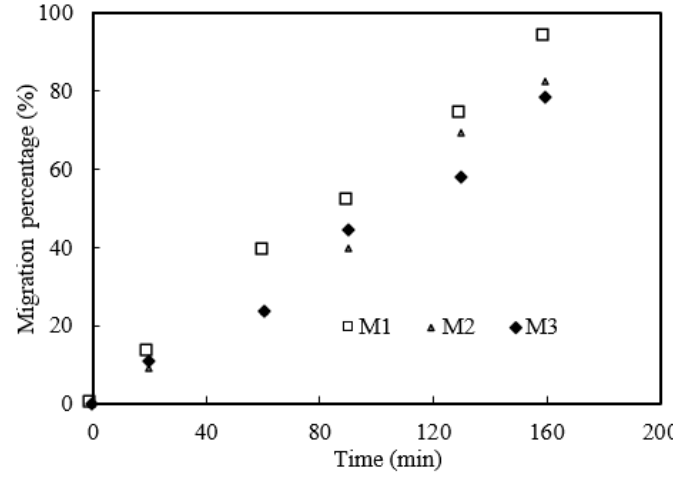
Figure 16. Effect of microtubule thickness.